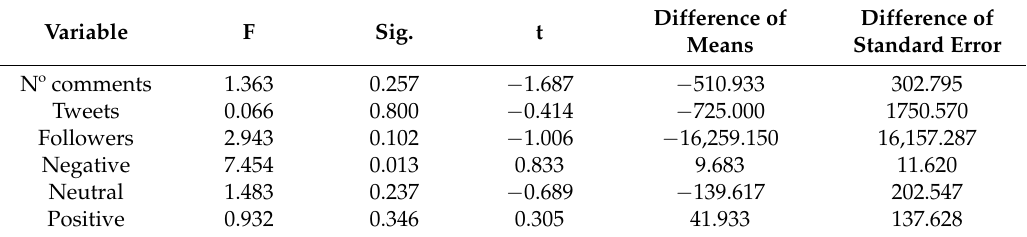
Table 16. Differences of means test